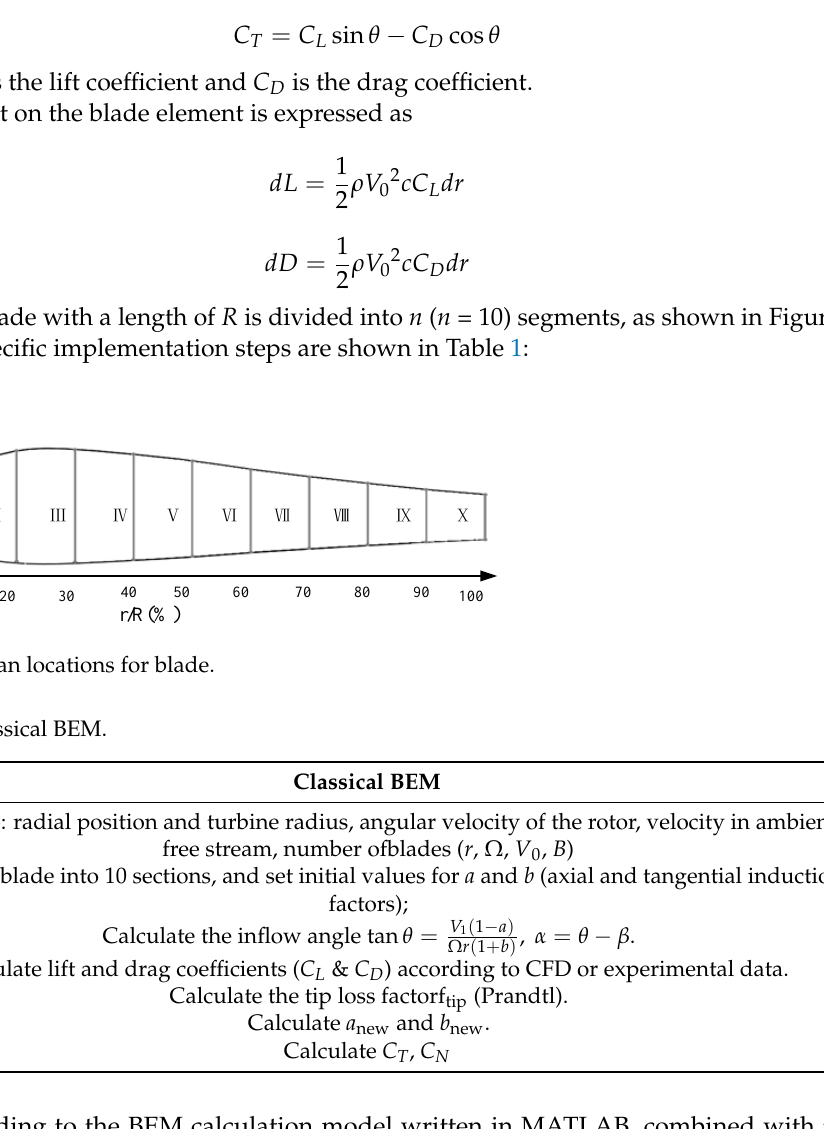
Table 1. Classical BEM.